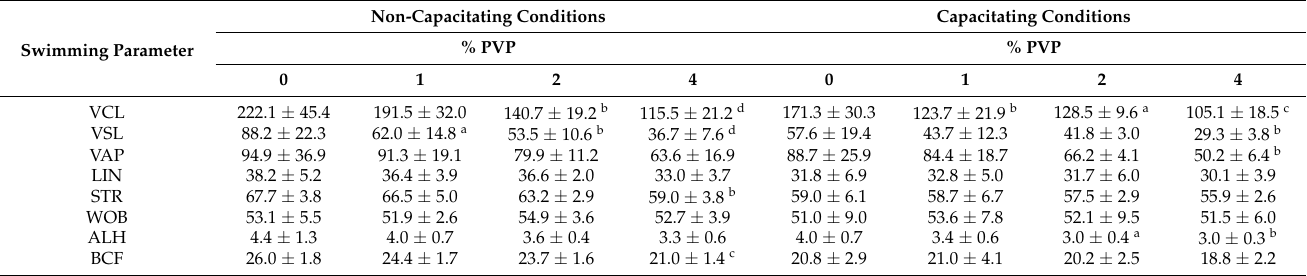
Table 3. Effect of various concentrations of PVP on the kinetics of spermatozoa from Mus spicilegus incubated under non-capacitating conditions (mT-H medium under air) or capacitating conditions (mT-BH medium under 5%CO 2 /air) for 30 min. VCL: curvilinear velocity; VSL: straight-line velocity; VAP: average path velocity; LIN: linearity; STR: straightness; WOB: wobble coefficient; ALH: ampli- tude of lateral head; BCF: beat cross frequency. Means ± SE (N = 7) are reported. Letters indicate different levels of significance between different PVP concentrations and control (0% PVP) in Tukey’s post-hoc test ( a : p < 0.05; b : p < 0.01; c : p < 0.001; d : p <